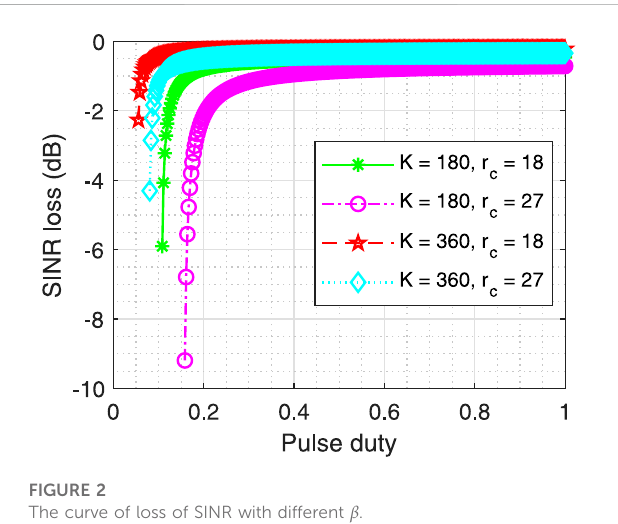
FIGURE 2 The curve of loss of SINR with different β